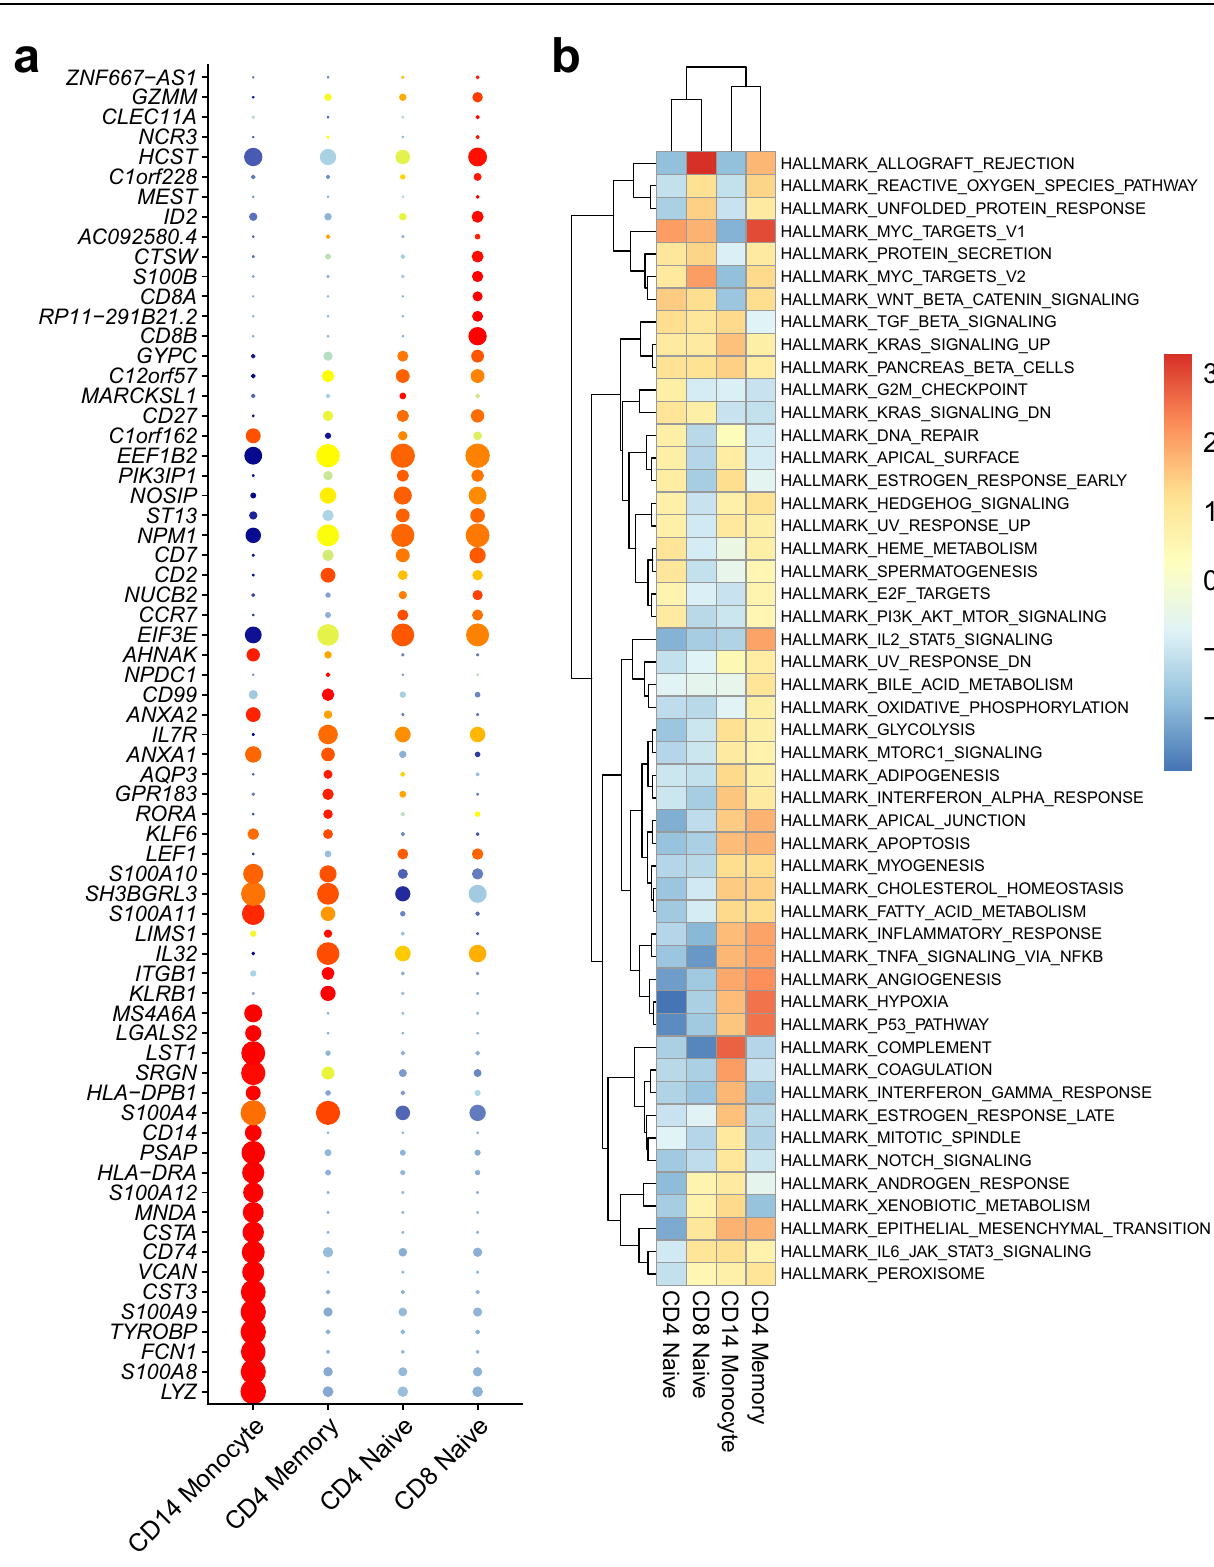
Fig.8|DownstreamanalysesofscMDCinBMNCdataset. Differentialexpression analyses( a ) and Hallmarkgene set enrichment analyses ( b ) areconducted forfour large cell clusters in the BMNC dataset based on the clustering result of scMDC. In